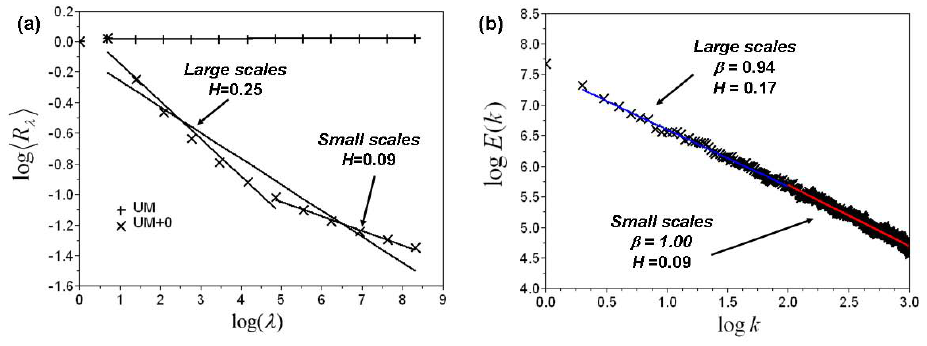
Fig. 4. Estimation of the non-conservation parameter Bare H (a) and Dressed H through the spectral behaviour (b) for simulation parameters C 1 = 0 . 1, α = 1 . 9, γ 0 = 0 . 1 and p 0 = 0 . 5.